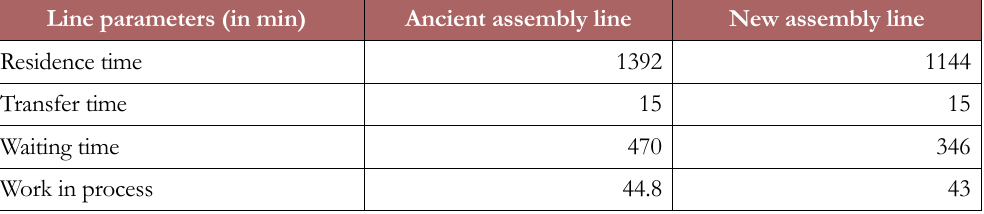
Table 6. The assembly line